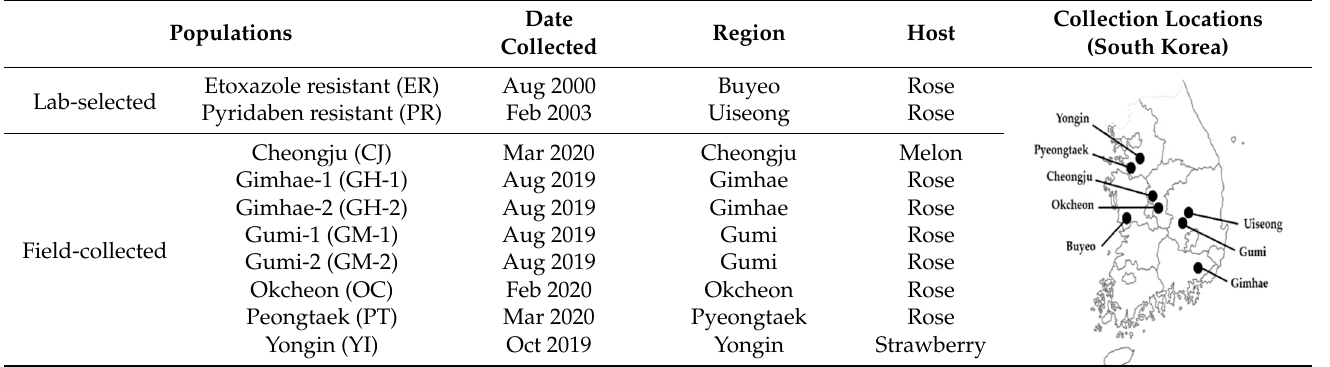
Table 1. Collection data of mite populations included in this study.